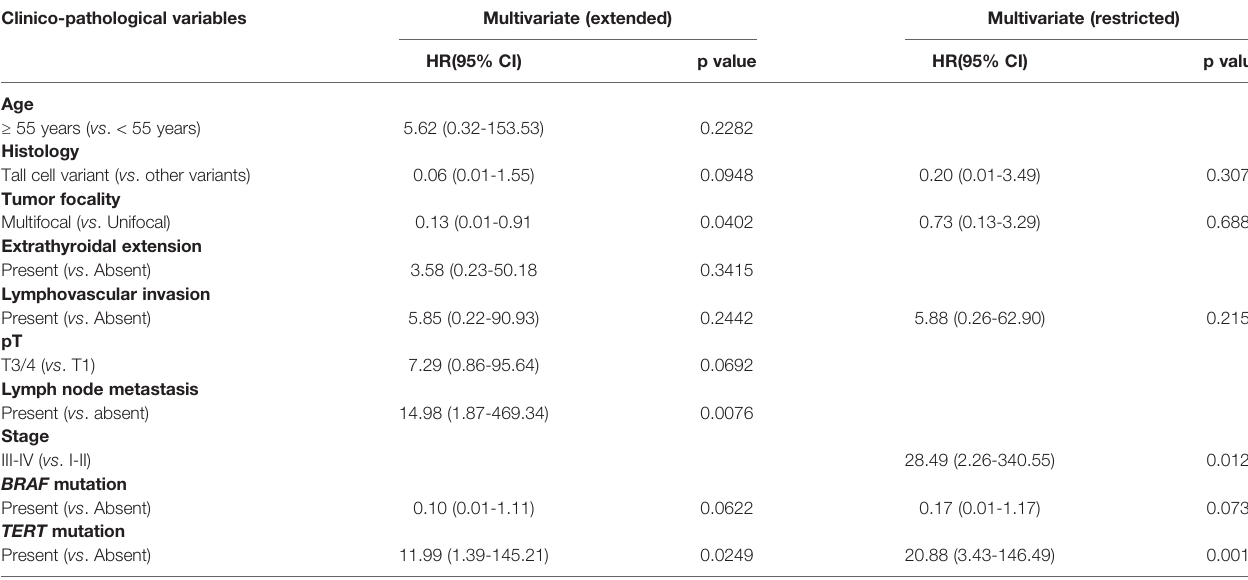
TABLE 4 | Multivariate analysis using Cox proportional hazards model for metastasis-free